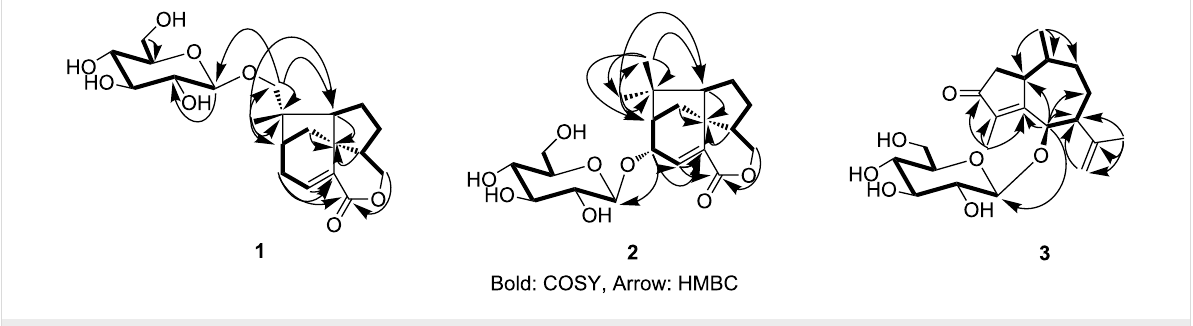
Figure 3: COSY and HMBC correlations of compounds 1 – 3 .